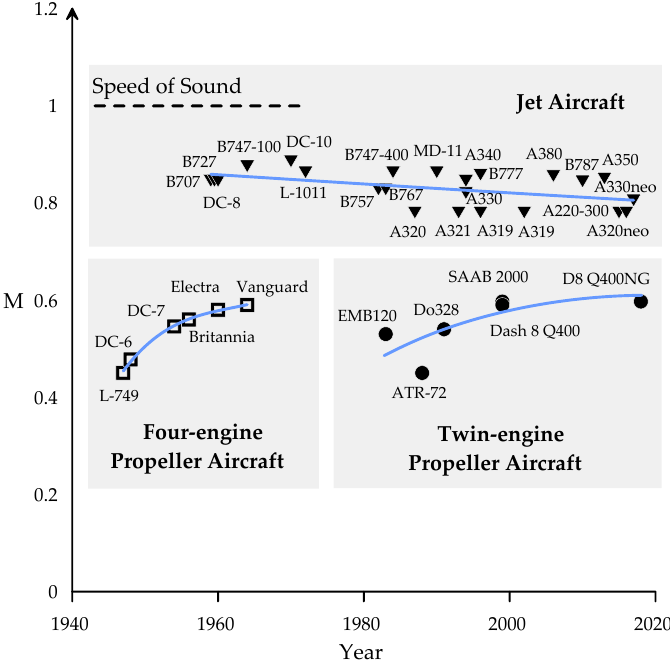
Figure 4. Historical development in maximum cruise speeds for commercial aircraft.